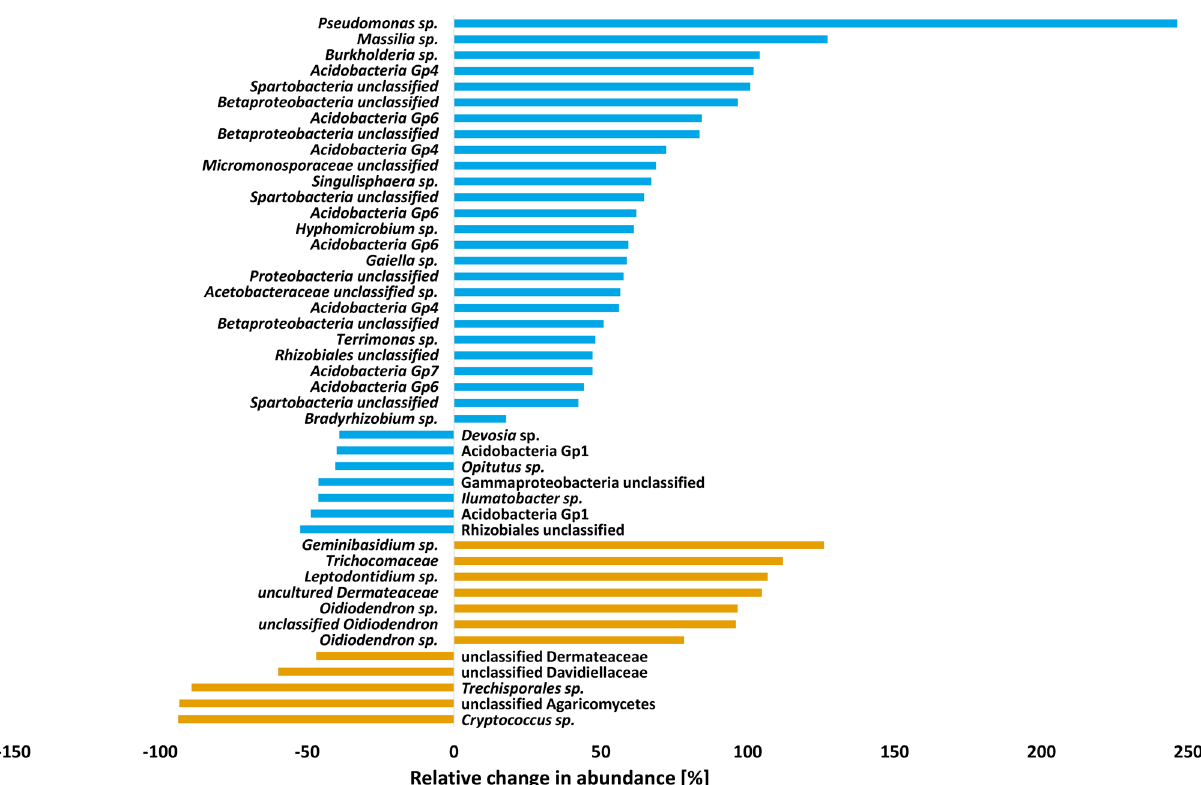
Figure 6. Relative change in abundance [%] of bacterial and fungal OTUs in the rhizobiome that increased (right) or decreased (left) due to the additional light treatment compared to normal light conditions. OTUs are named according to the highest resolved tax level. Blue: bacteria, orange: